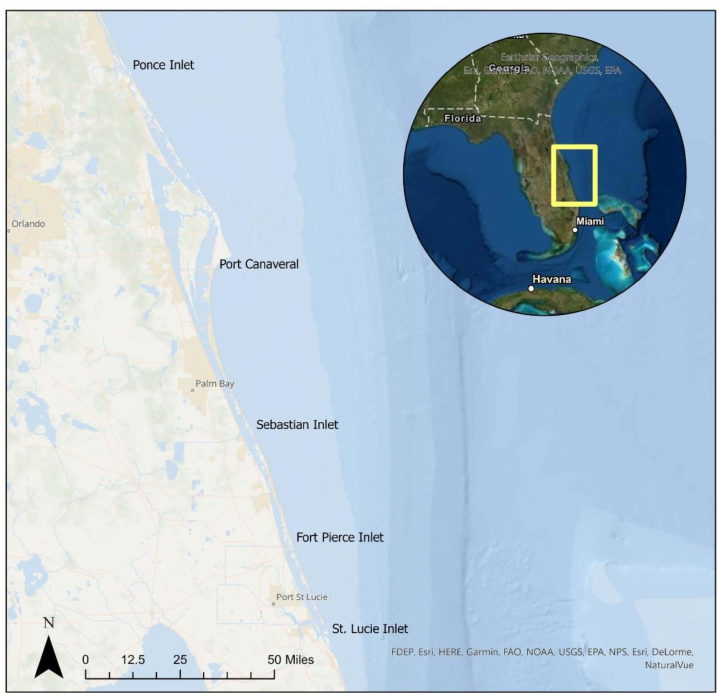
Figure 2. Indian River Lagoon in Florida, USA, with major inlets.